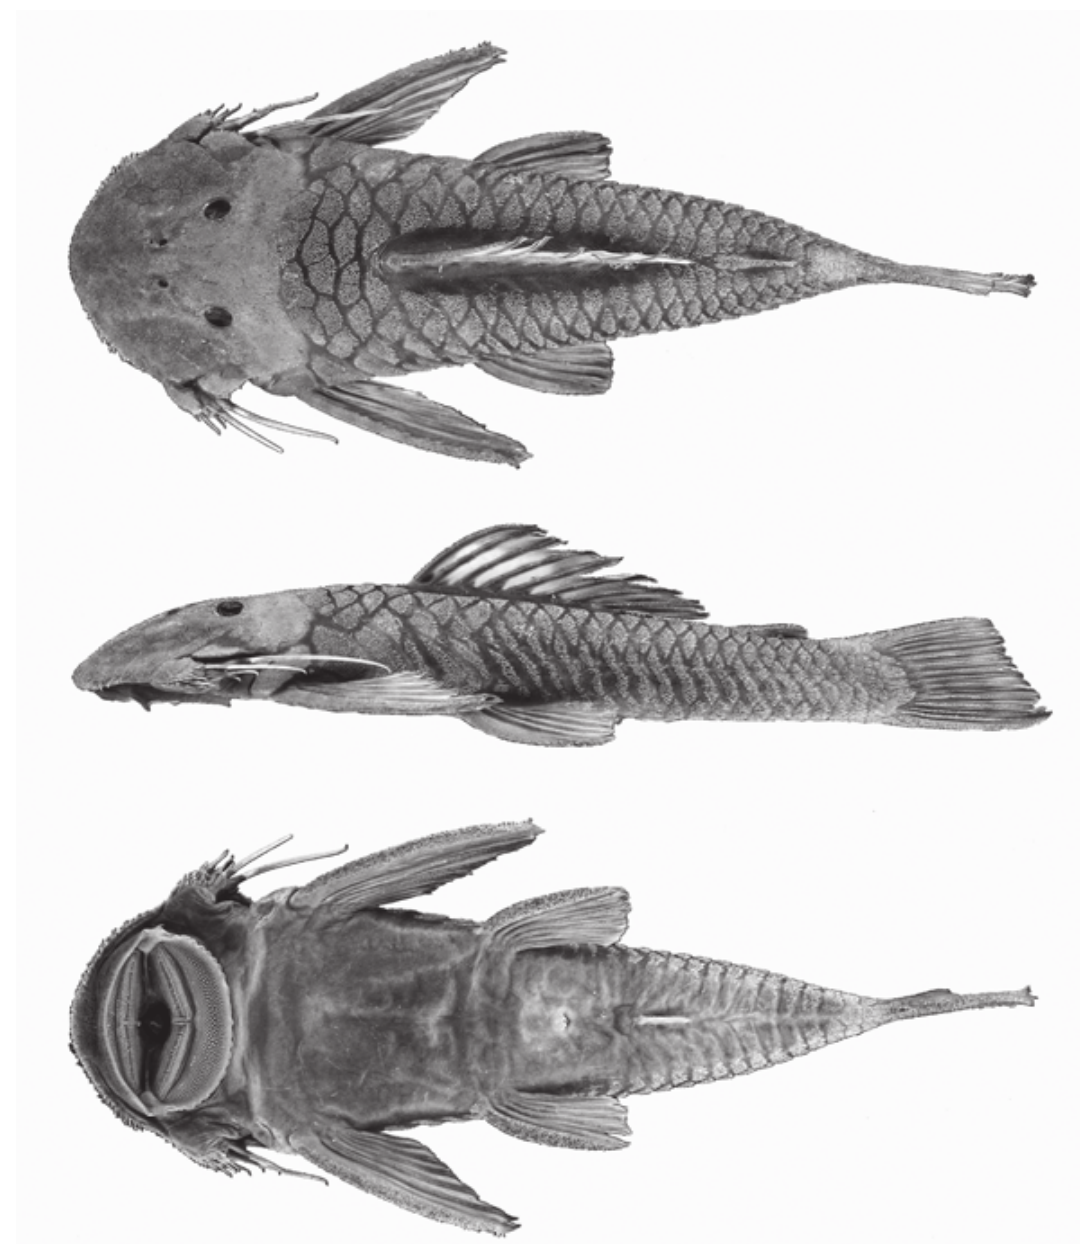
Fig. 1. Dolichancistrus atratoensis , CIUA 768, 120.3 mm SL. Colombia, Departamento de Antioquia, quebrada la Selva; dorsal, lateral and ventral